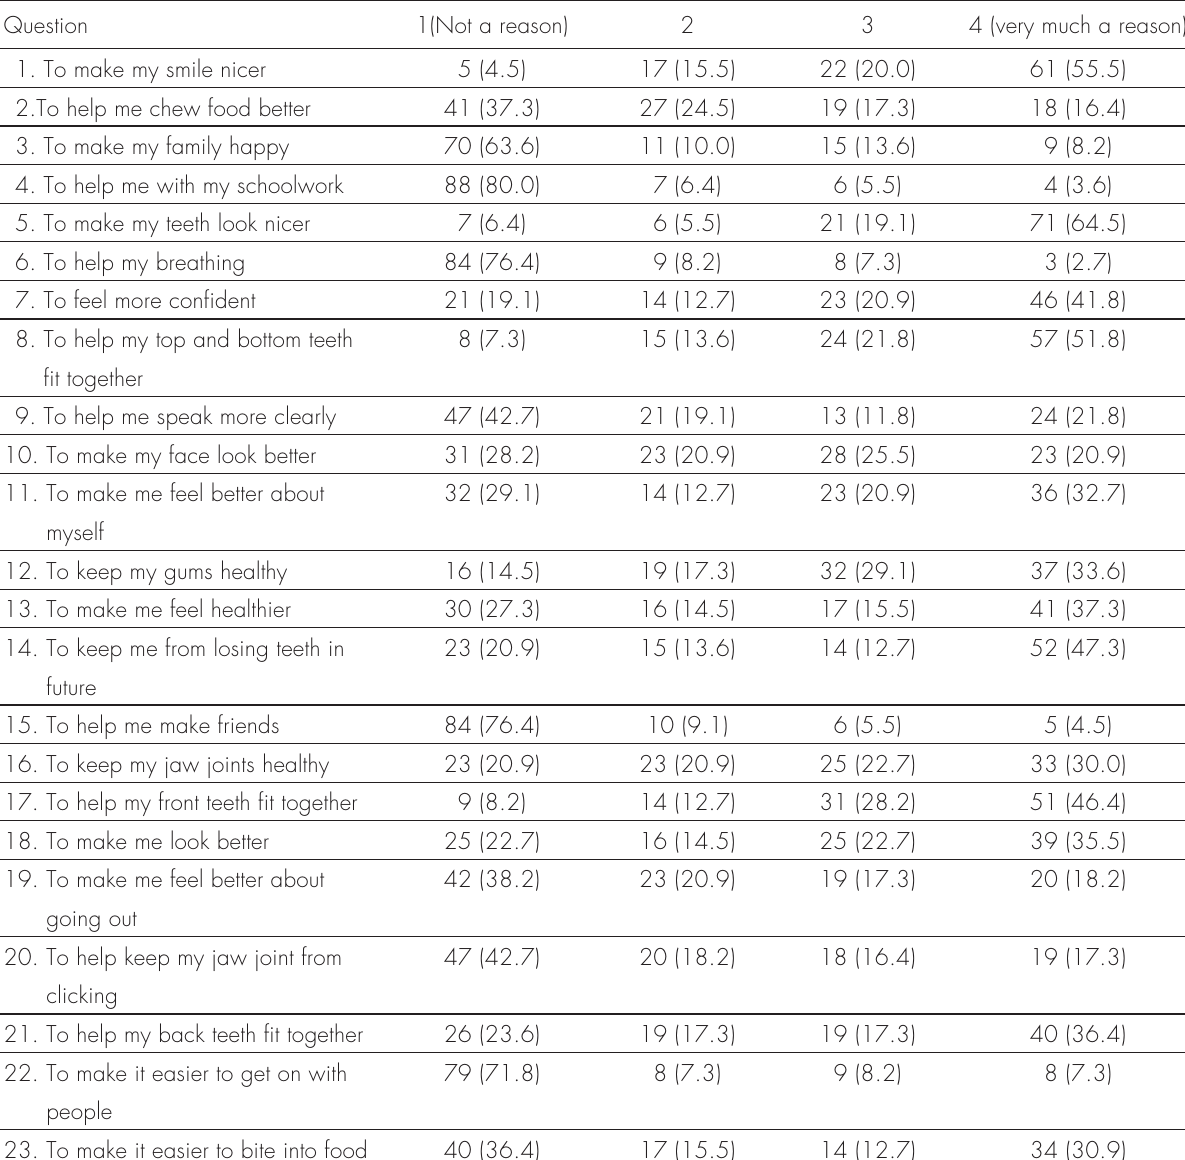
Table IV. Responses to questionnaire administered to